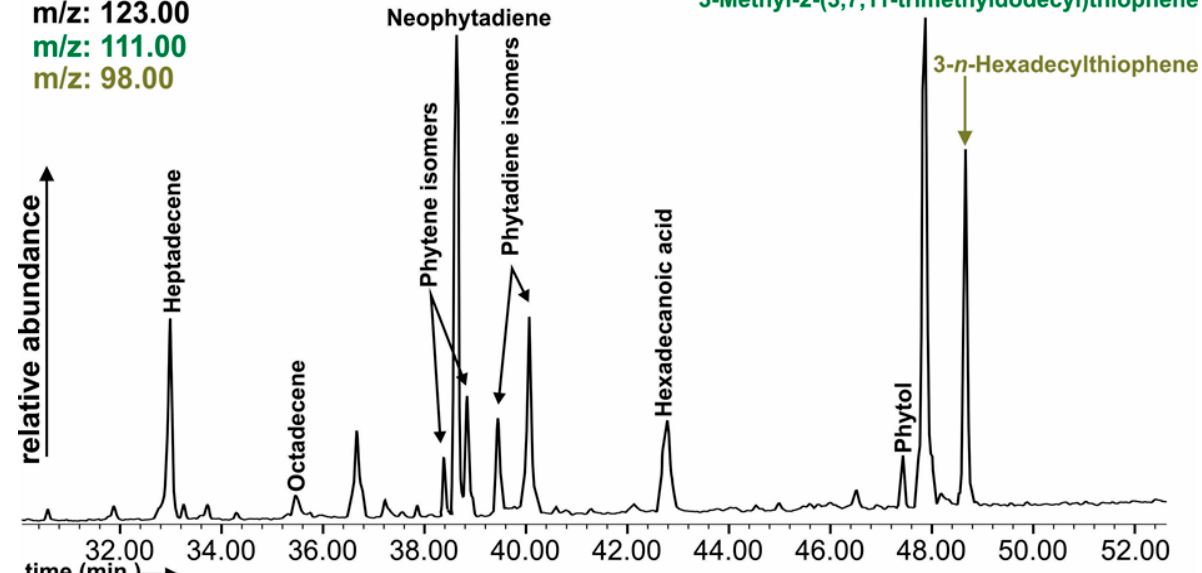
Figure 4. Representative chromatogram of organic sulphur compounds (OSC) and terpane-related compounds in profile 1 sample.